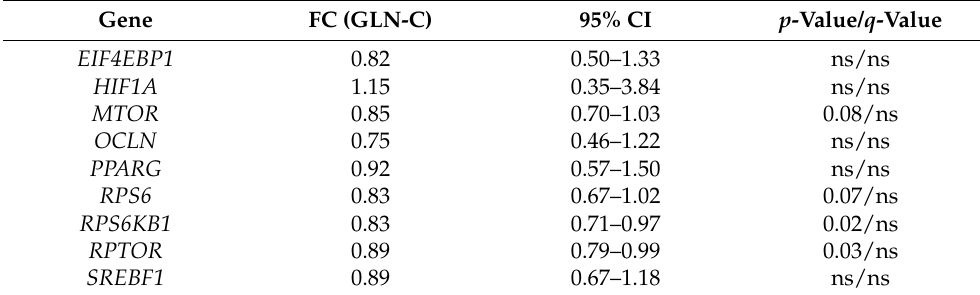
Table 2. Expression of target genes in control and treated (GLN) newborns at birth.